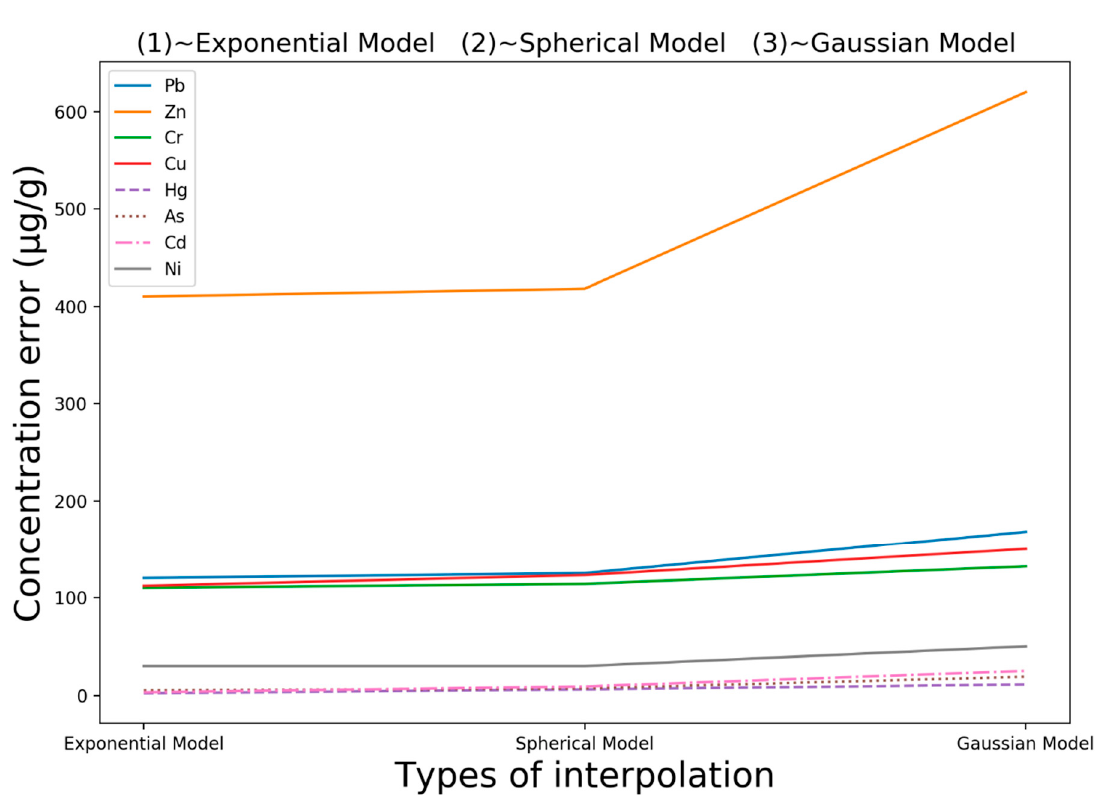
ff ect diagram of the three variance functions. Figure 5. The effect diagram of the three variance functions. Figure 5. The e In Figure 5, the abscissa axis represents the three variograms: the exponential model, spherical model and Gaussian model, while the vertical axis represents the RMSPE values under the three variograms. As seen from the above figure, the RMSPE of the Gaussian model for the eight heavy metals is obviously higher than that of the first two variograms, so the Gaussian model is not suitable for the kriging interpolation. Compared with the first two models, the RMSPE of the exponential model is larger than that of the spherical model for Cd, indicating that the e ff ect of the spherical model is better than that of the exponential model. Similarly, the interpolation e ff ect of the other seven heavy